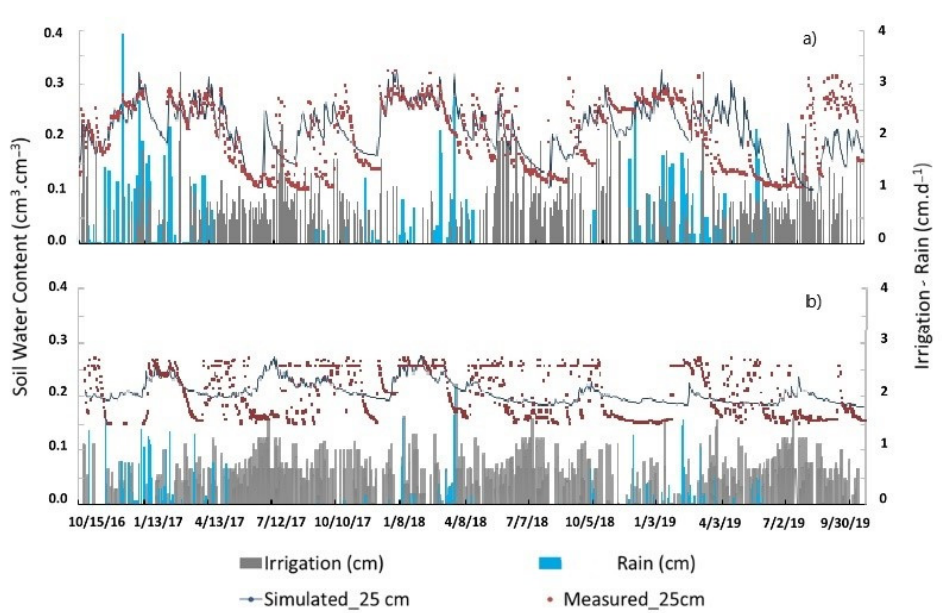
Figure 2. Effects of irrigation and rain on the measured and HYDRUS-1D simulated soil water contents at a depth of 25 cm at the ASL site ( a ) and the ASH site ( b ). Table 5. RMSE (dimensionless) for simulated volumetric water content and measured. ASH, West SJV, CA ASL, East SJV, CA